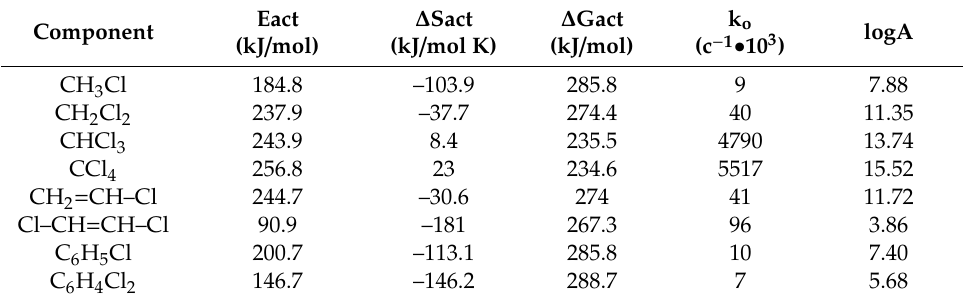
Calculated thermodynamic characteristics for hydrodechlorination of various chlorohydrocarbons. Temperature of 700 ◦